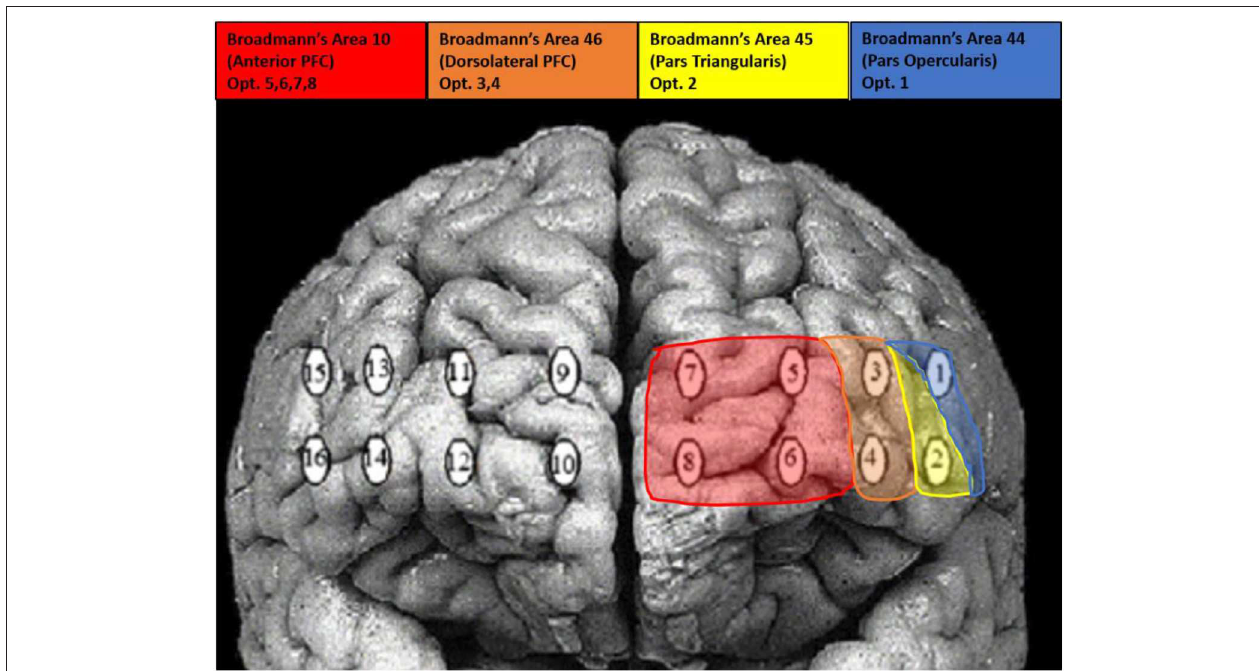
FIGURE 4 | Visualization of optode locations and Broadmann’s